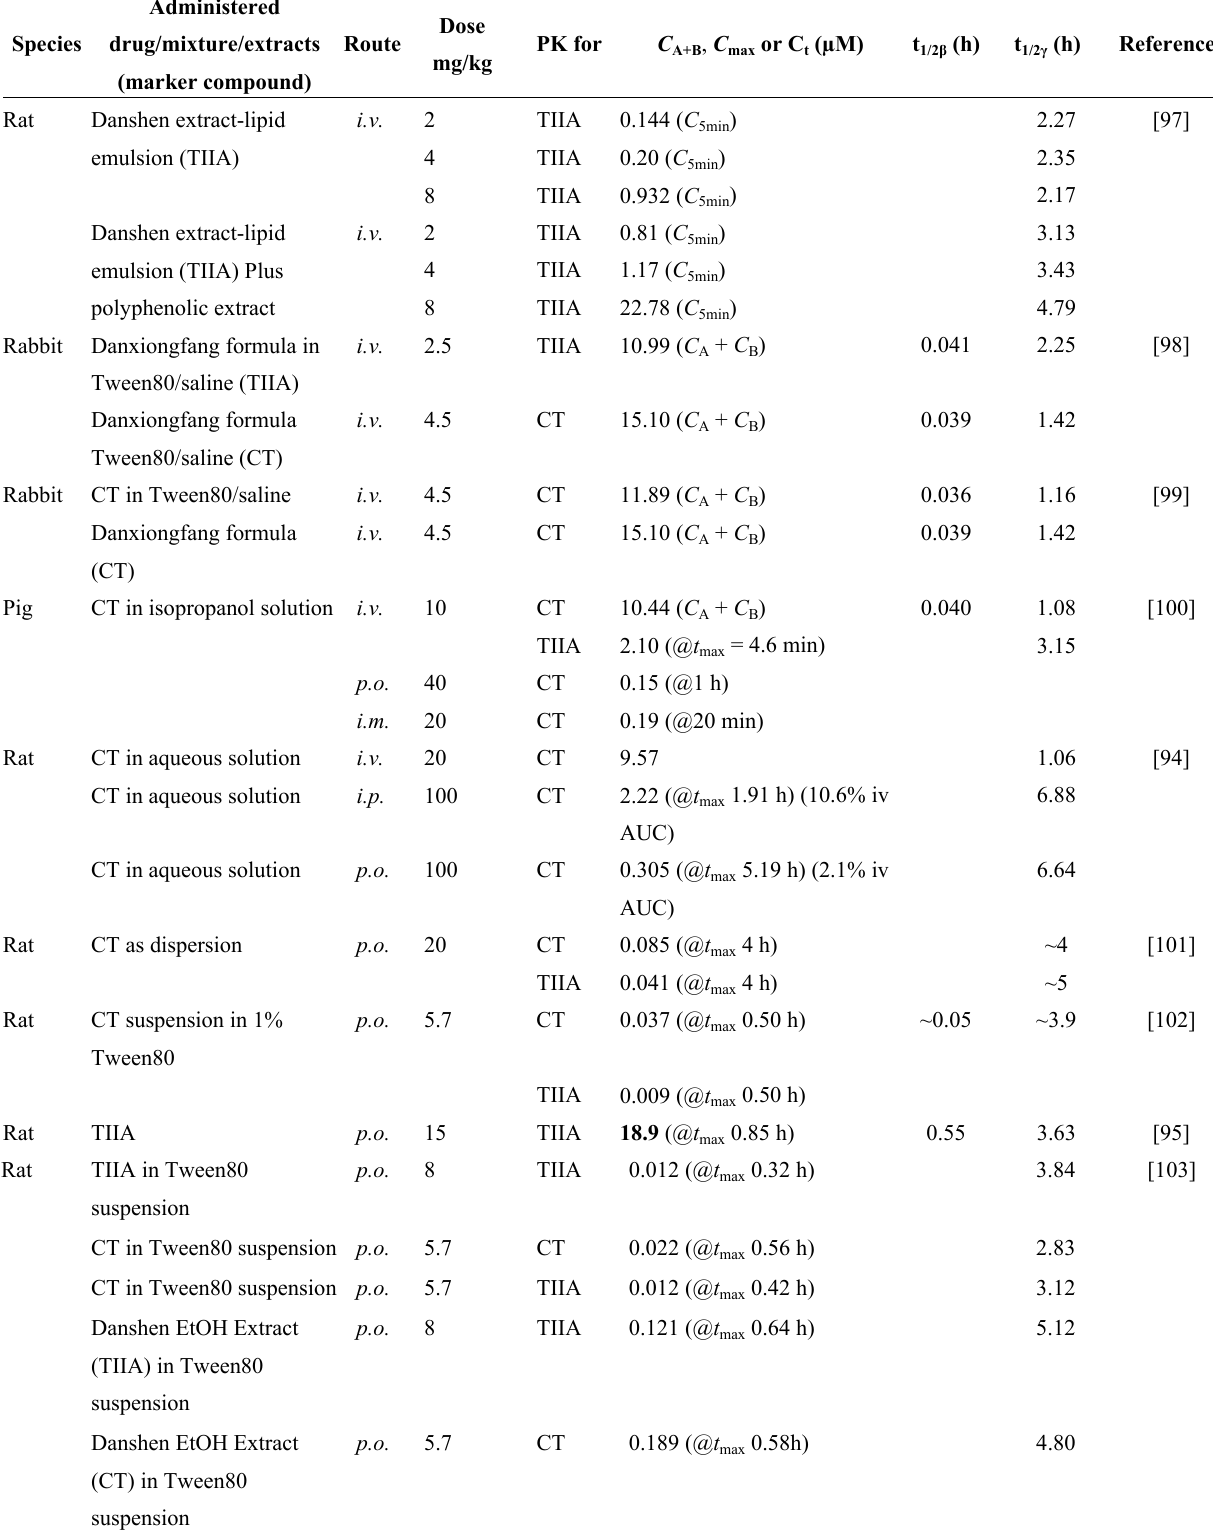
Table 2. Pharmacokinetic parameters of selected tanshinones (TIIA, CT, TI and